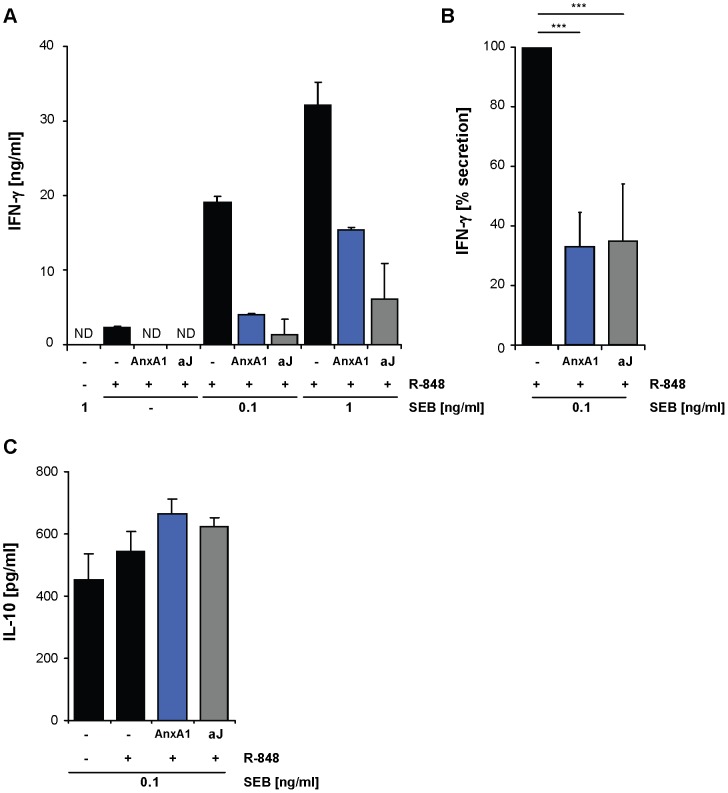
Annexin A1 influences DC-mediated T cell stimulation.(A) Immature DC were incubated with annexin A1 (AnxA1, 20 µg/ml), apoptotic Jurkat T cells (aJ), or left untreated. 2 days after stimulation by R-848, autologous T cells together with SEB in the indicated concentrations were added to the culture. The concentration of IFN-γ in culture supernatants was determined by ELISA after 6 days. Error bars represent means +/− SD of quadruplicate cultures. (B) For several donors, the relative IFN-γ secretion of cultures treated as in (A) is shown. IFN-γ-secretion in cultures with treated DC was calculated relative to cultures with DC stimulated by R-848 only, which was set to 100%. Error bars represent means +/− SD (n = 7). ***P<0.001. (C) Cocultures were set up as in (A) and concentrations of IL-10 in culture supernatants were determined by ELISA after 4 days. Error bars represent means +/− SD of triplicate cultures. Data are representative of at least 3 independent experiments. In all experiments, R-848 was used at a concentration of 5 or 10 µg/ml.